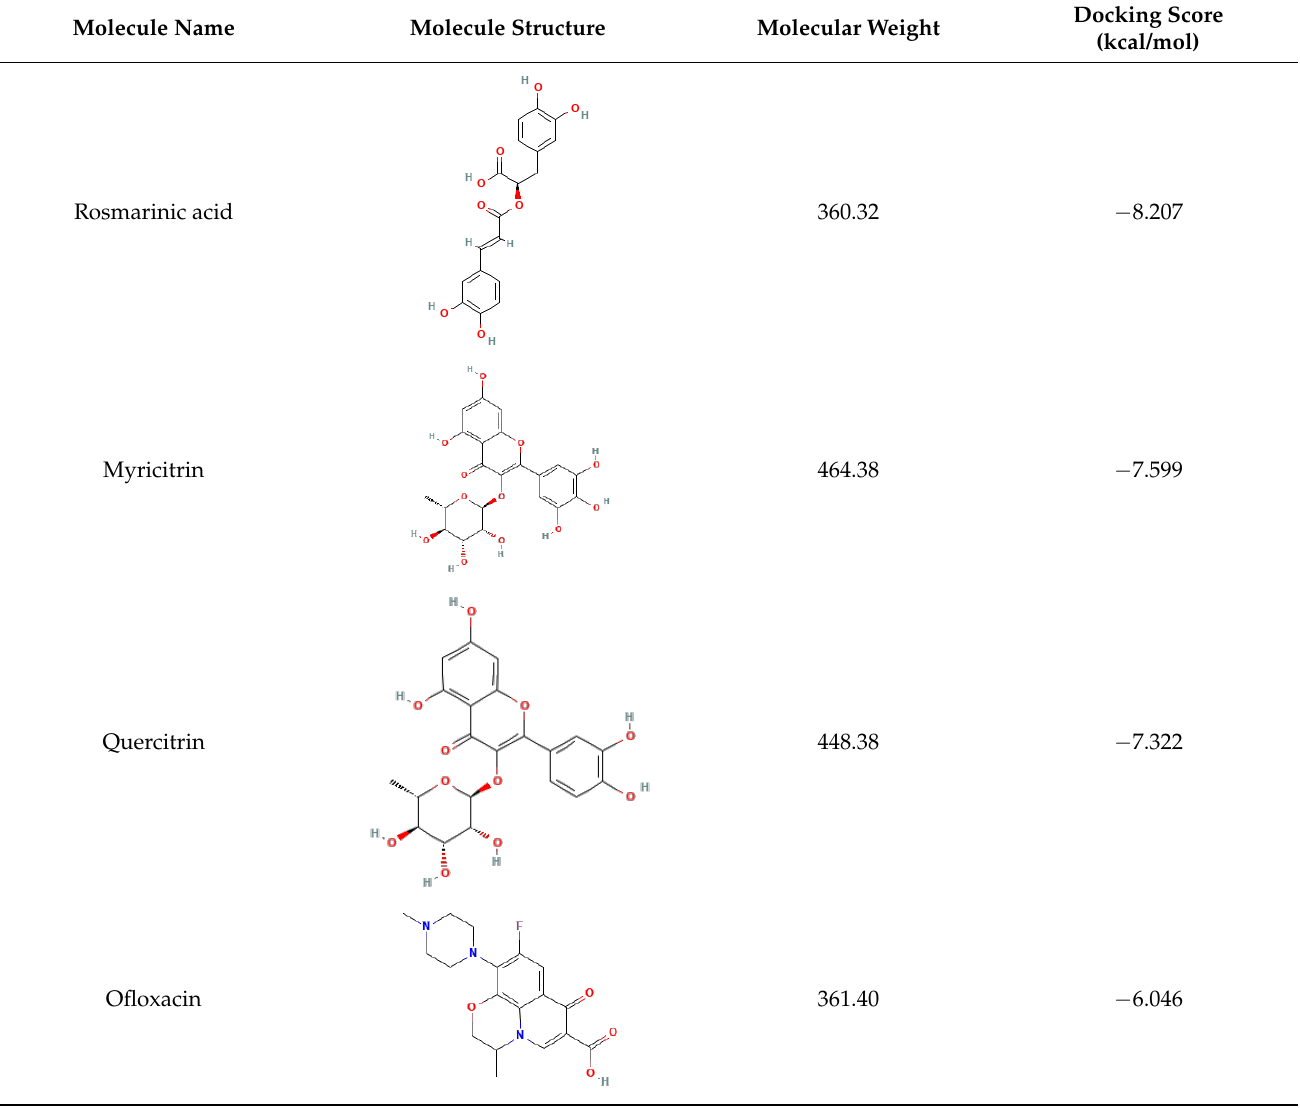
Table 1. The chemical features and docking scores between TOP1 and selected compounds.